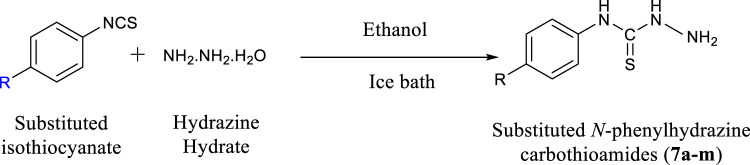
Synthesis of substituted N-phenylhydrazine carbothioamides (7a-m).